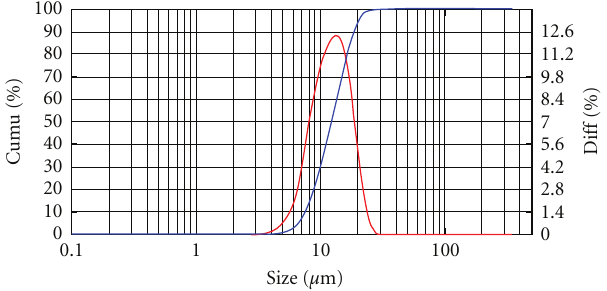
0.1 Figure 5: Particle size distribution of [Ni 0 . 5 Mn 0 . 3 Co 0 . 2 ](OH) 2 pre- cursor.